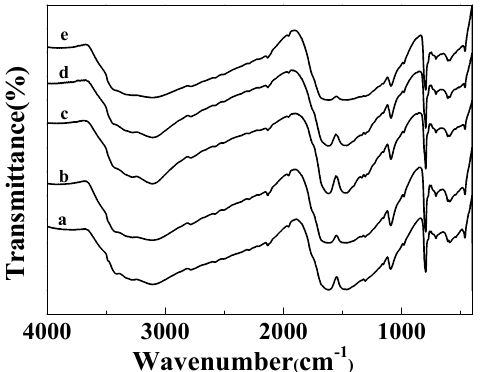
Figure 2. FT-IR spectra of ( a ) tri-g-C 3 N 4 , ( b ) 1CoO x / tri-g-C 3 N 4 , ( c ) 3CoO x / tri-g-C 3 N 4 , ( d ) 5CoO x / tri-g-C 3 N 4 , and ( e ) 7CoO x / tri-g-C 3 N 4 .